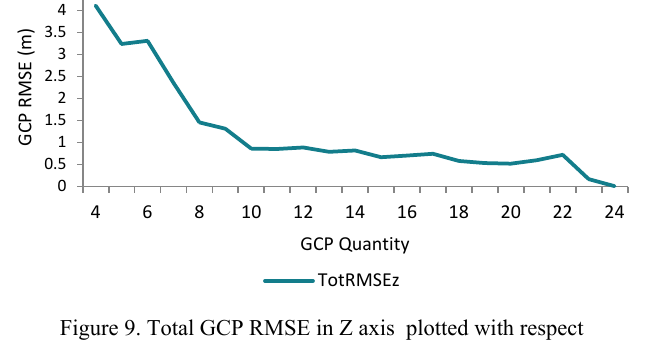
Figure 9. Total GCP RMSE in Z axis plotted with respect to the GCP Quantity